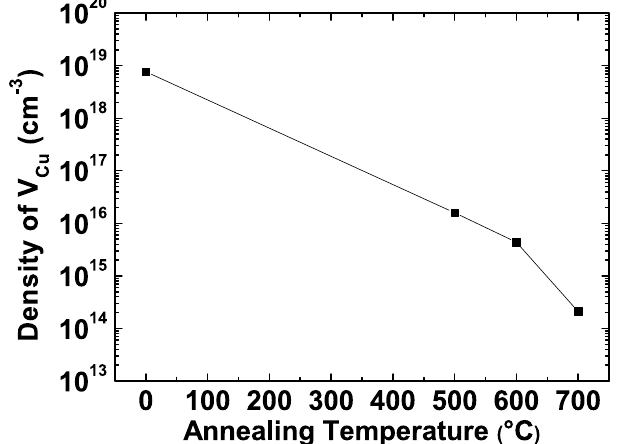
Figure 5. Extracted density of copper vacancies as a function of annealing